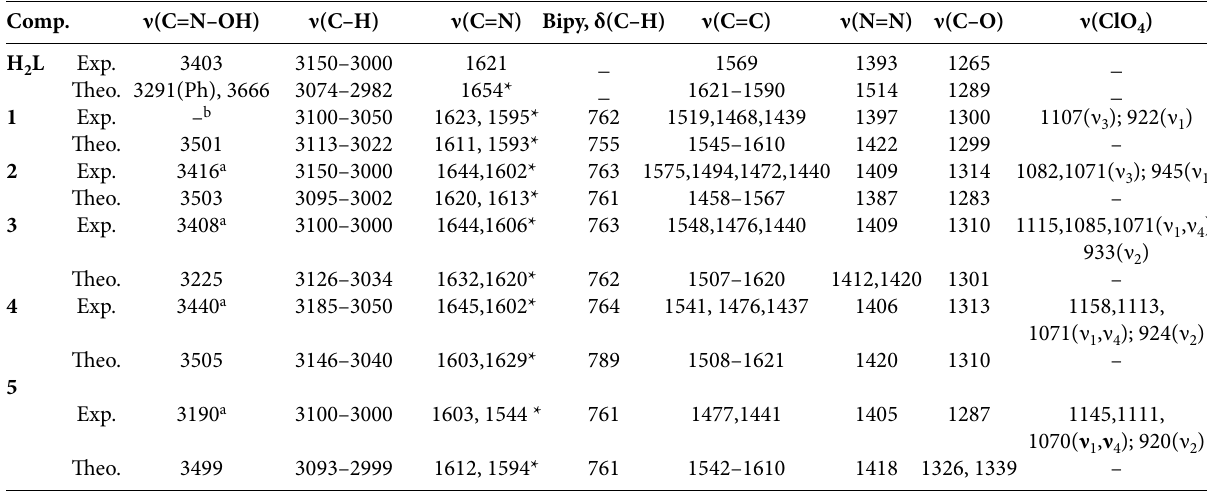
Table 4. Selected vibrational frequencies (observed and calculated, cm –1 ) of synthesized compounds. Comp.